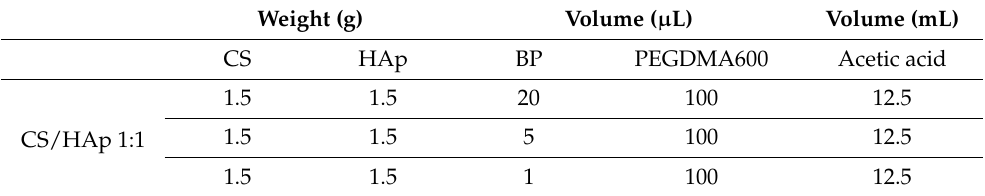
Table 4. Scaffold compositions with various benzophenone concentrations. Weight (g) Volume ( µ L) Volume (mL) CS HAp BP PEGDMA600 Acetic